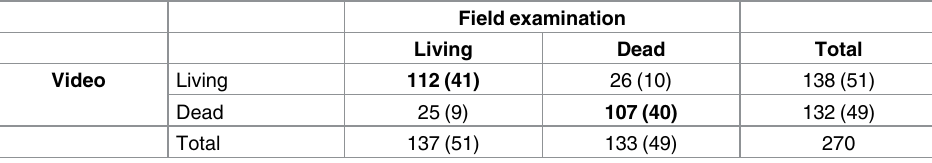
Table 2. Identification of individual oysters.